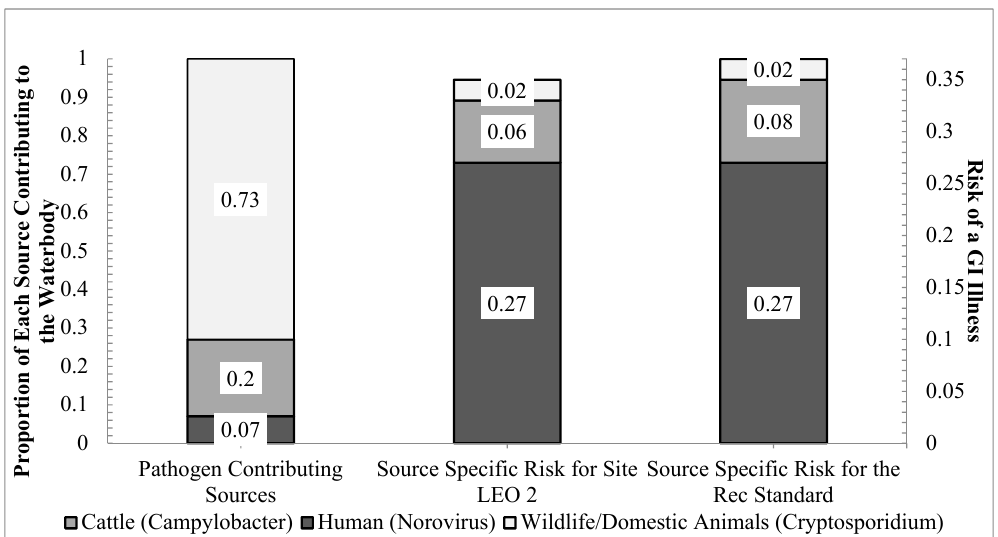
Figure 3. Contribution of each source to the health risk under Scenario 3 (each source contributes according to the modified MST results). LEO 2 had an E. coli concentration of 163 cfu 100 mL − 1 and the recreational standard had an E. coli concentration of 126 cfu 100 mL − 1 .